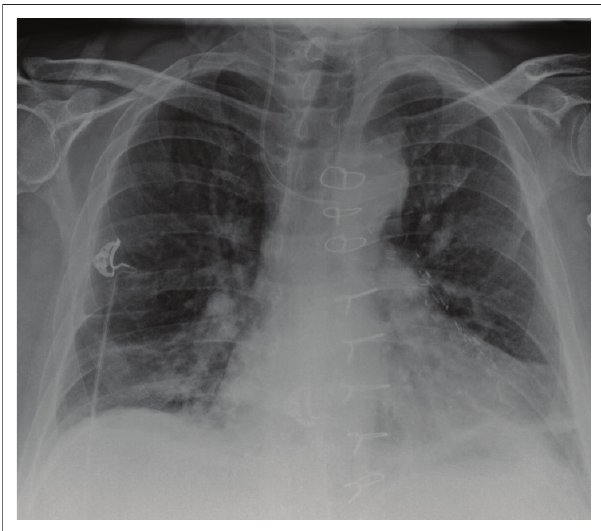
FIGURE 6: Magnified chest radiograph showing a malpositioned right central venous catheter in the left brachiocephalic vein.